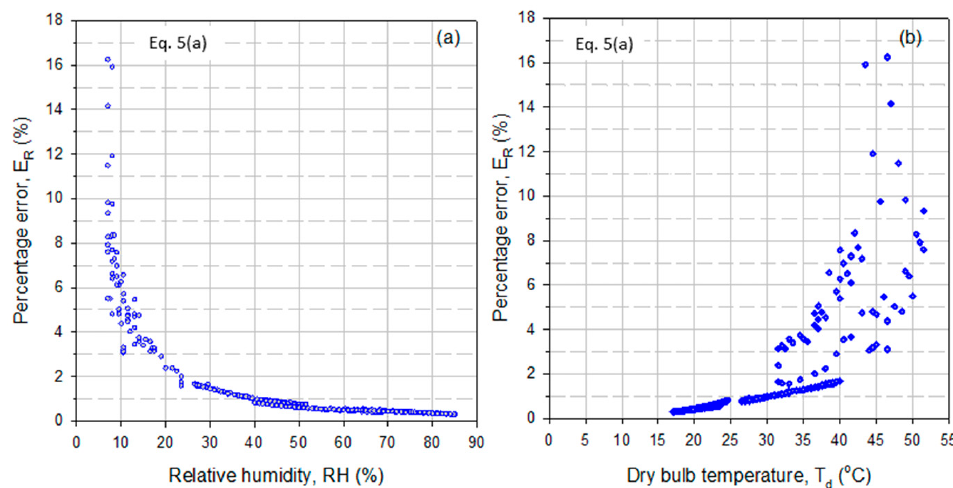
Figure 9. Percentage error, E R (%), in the approximated value of T dp (estimated by using Equation (5a)) as affected by ( a ) relative humidity ( RH ) and ( b ) dry bulb temperature ( T d ).